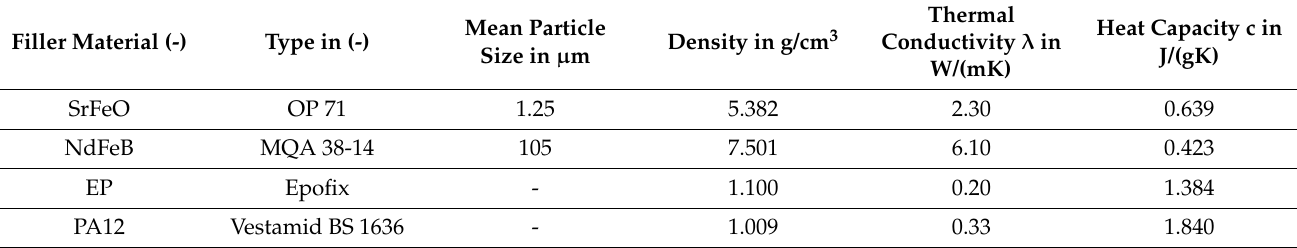
Table 1. Specification of filler and matrix material including mean particle size of filler (manufacturer specifications) and density, thermal conductivity and heat